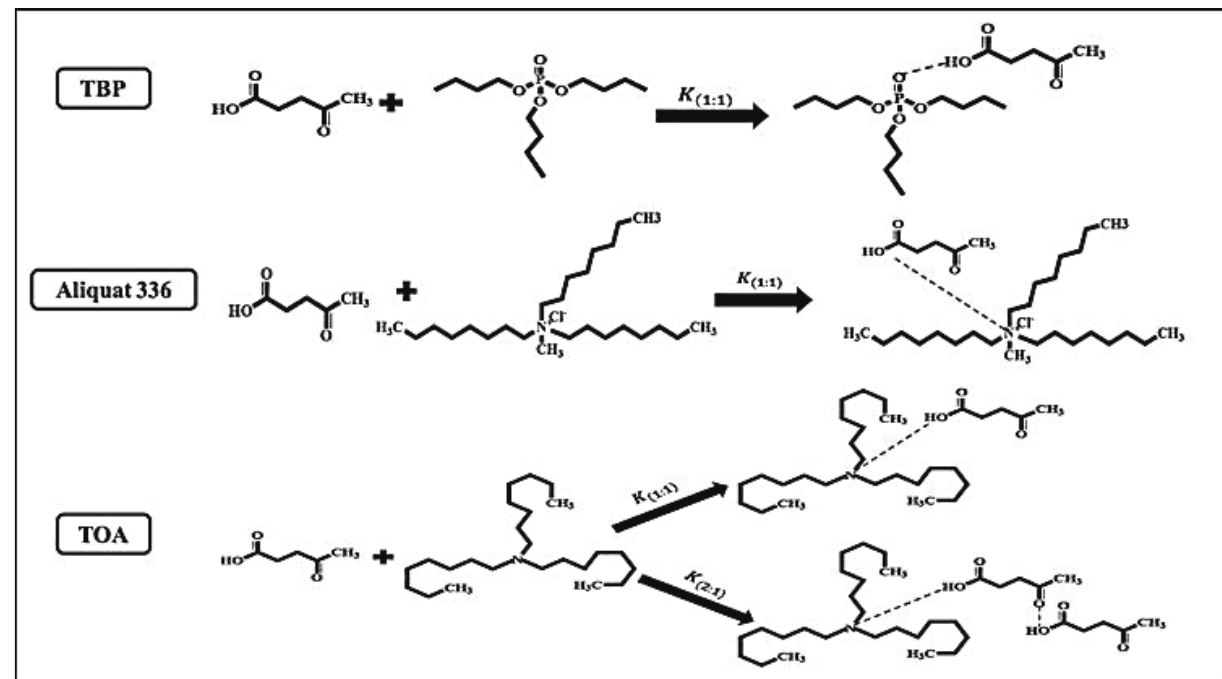
Fig. 4 – Complex formation (a) LA with TBP in the organic phase, (b) LA with Aliquat 336, (c) LA with